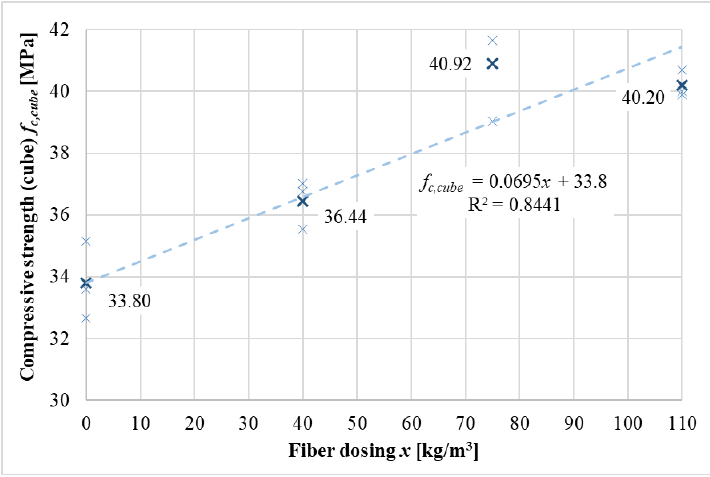
Figure 9. Regression analysis to determine the functional dependence of the compressive strength (cube) f c,cube on fiber dosage x .